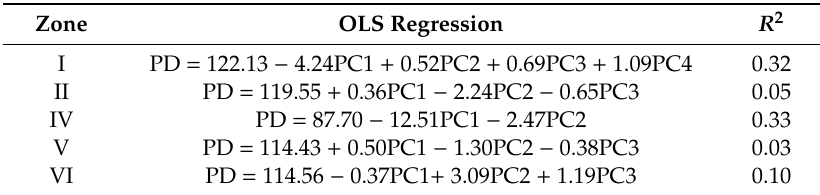
Table 4. Ordinary least squares (OLS) regression for spring maize in each zone. R 2 is the adjusted coe ffi cient of determination. PD is planting date (day of year).